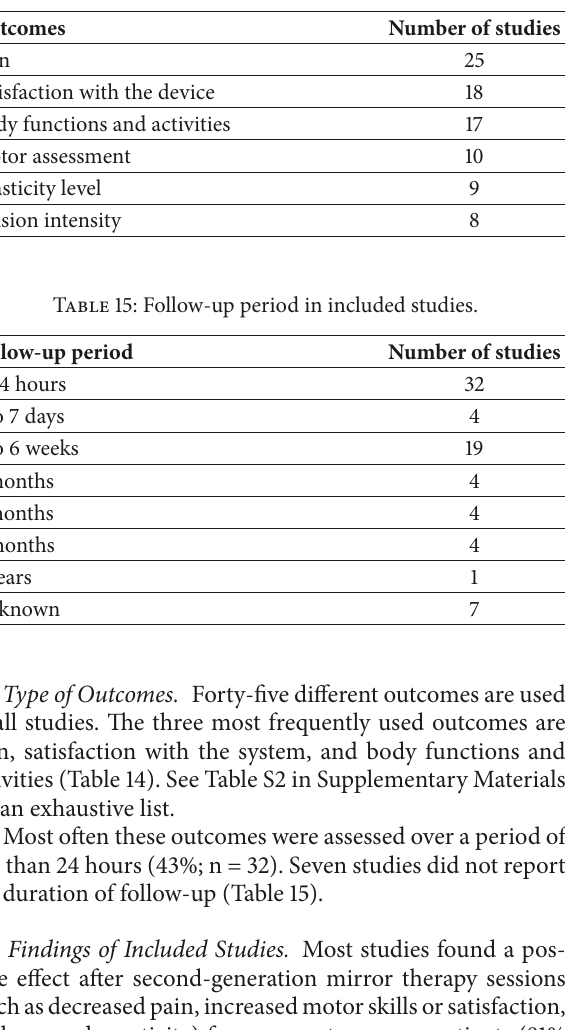
Table 14: The most frequently used outcomes in included studies.